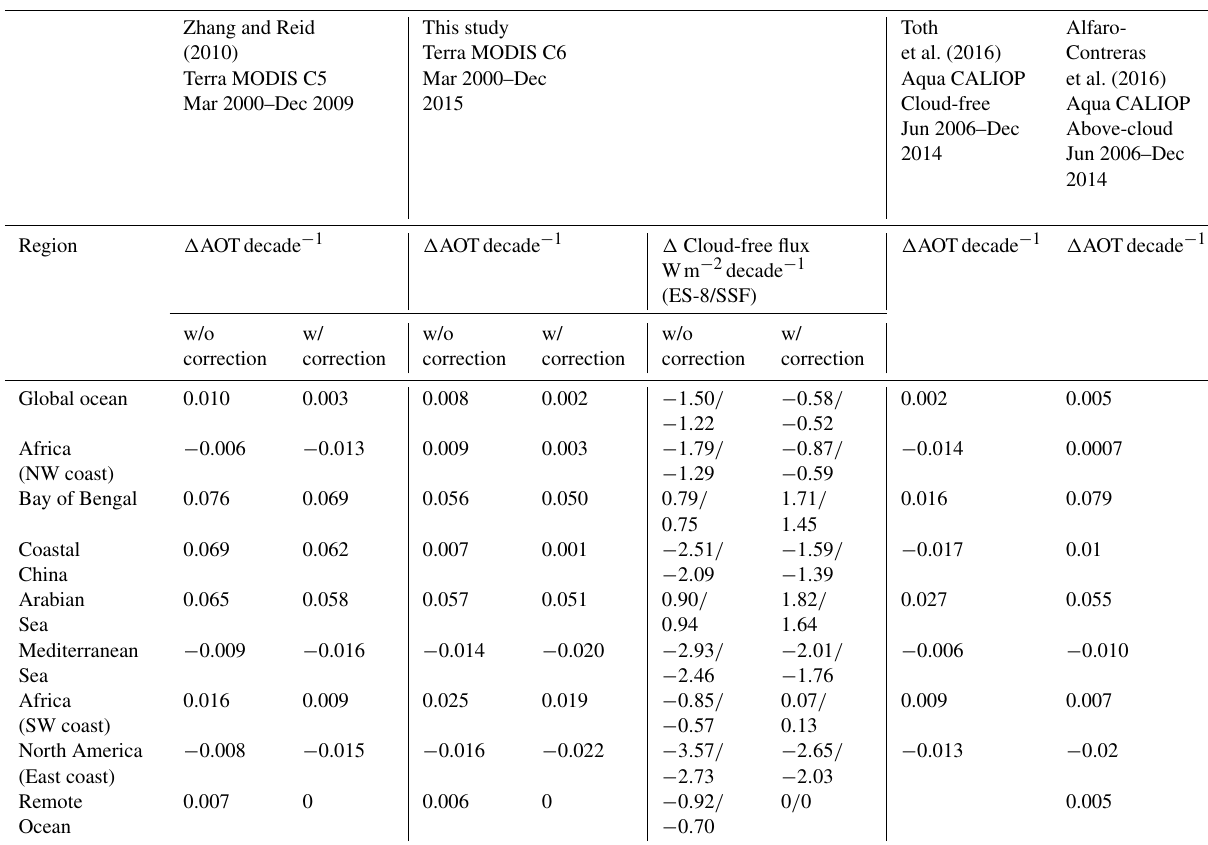
Table 6. Intercomparison of AOT (AOTdecade − 1 ) and SW flux (Wm − 2 decade − 1 ) trends from this study as well as a few previous studies on both regional and global scales. Trends for the same regions as defined in Table 3 are